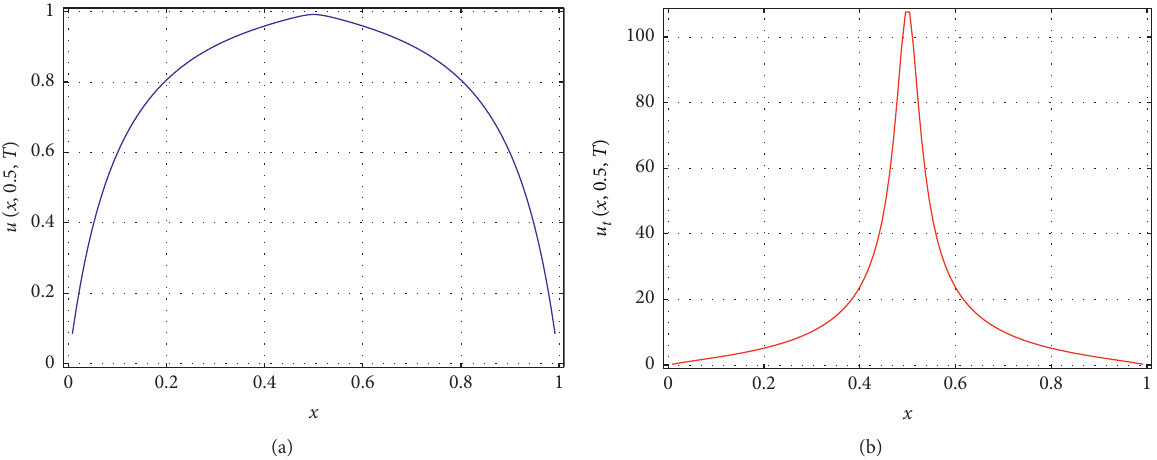
Figure 7: Profiles of the numerical solution u ( x,y, T ) (a) and u ( x, y, T ) (b), at y � 0 . 5 , T � 0 . 48141520 before quenching. The profiles are t highly symmetric with peaks at the center of the scaled dimensionless combustion domain. Boundary values are not